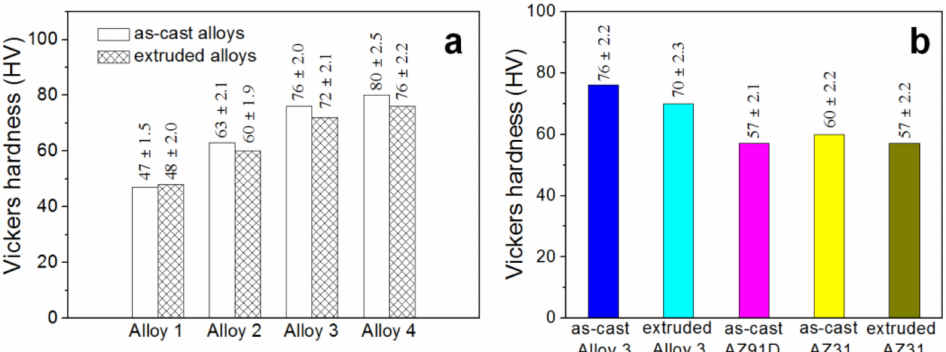
Figure 5. Micro-hardness of the experimental alloys: ( a ) Alloy 1–4; ( b ) Alloy 3 and commercial AZ31 and AZ91D alloys in various